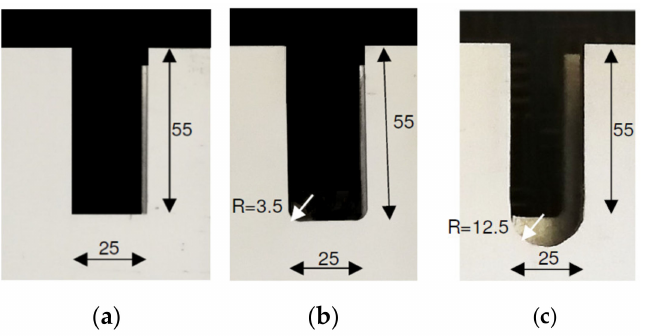
Figure 6. Geometry of the ( a ) sharp notch, N1, ( b ) rounded notch, N2, and ( c ) semi-circular notch